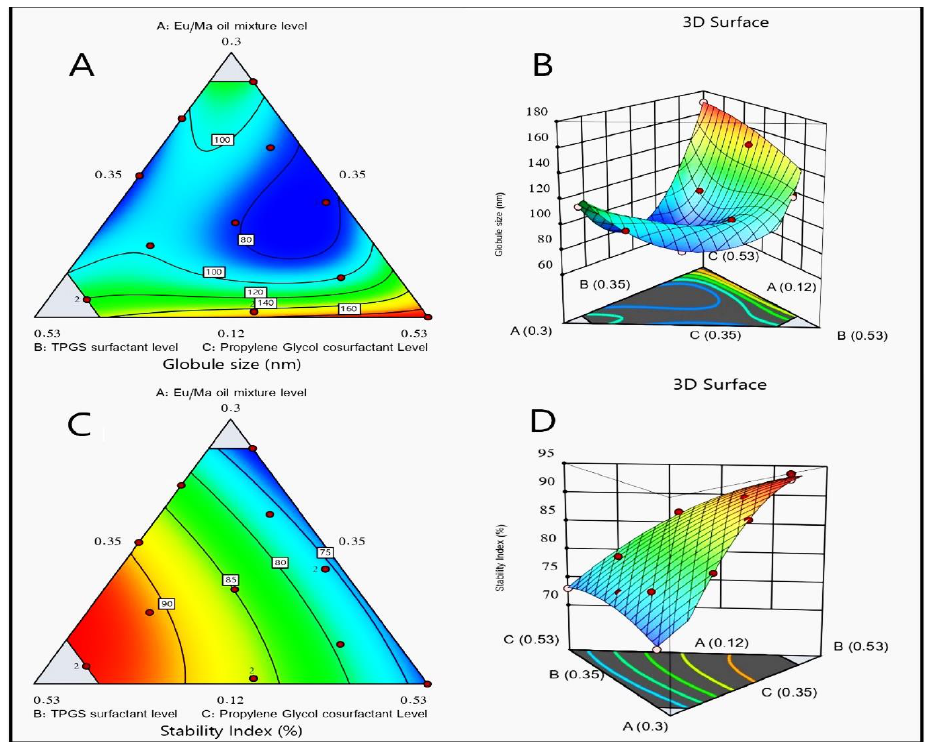
Figure 3. Statistical design plots for the droplet size and stability index of LV-Eu-SNEDDS: ( A ) contour plot for droplet size, ( B ) response surface plot for droplet size, ( C ) contour plot for stability index, and ( D ) response surface plot for stability index.